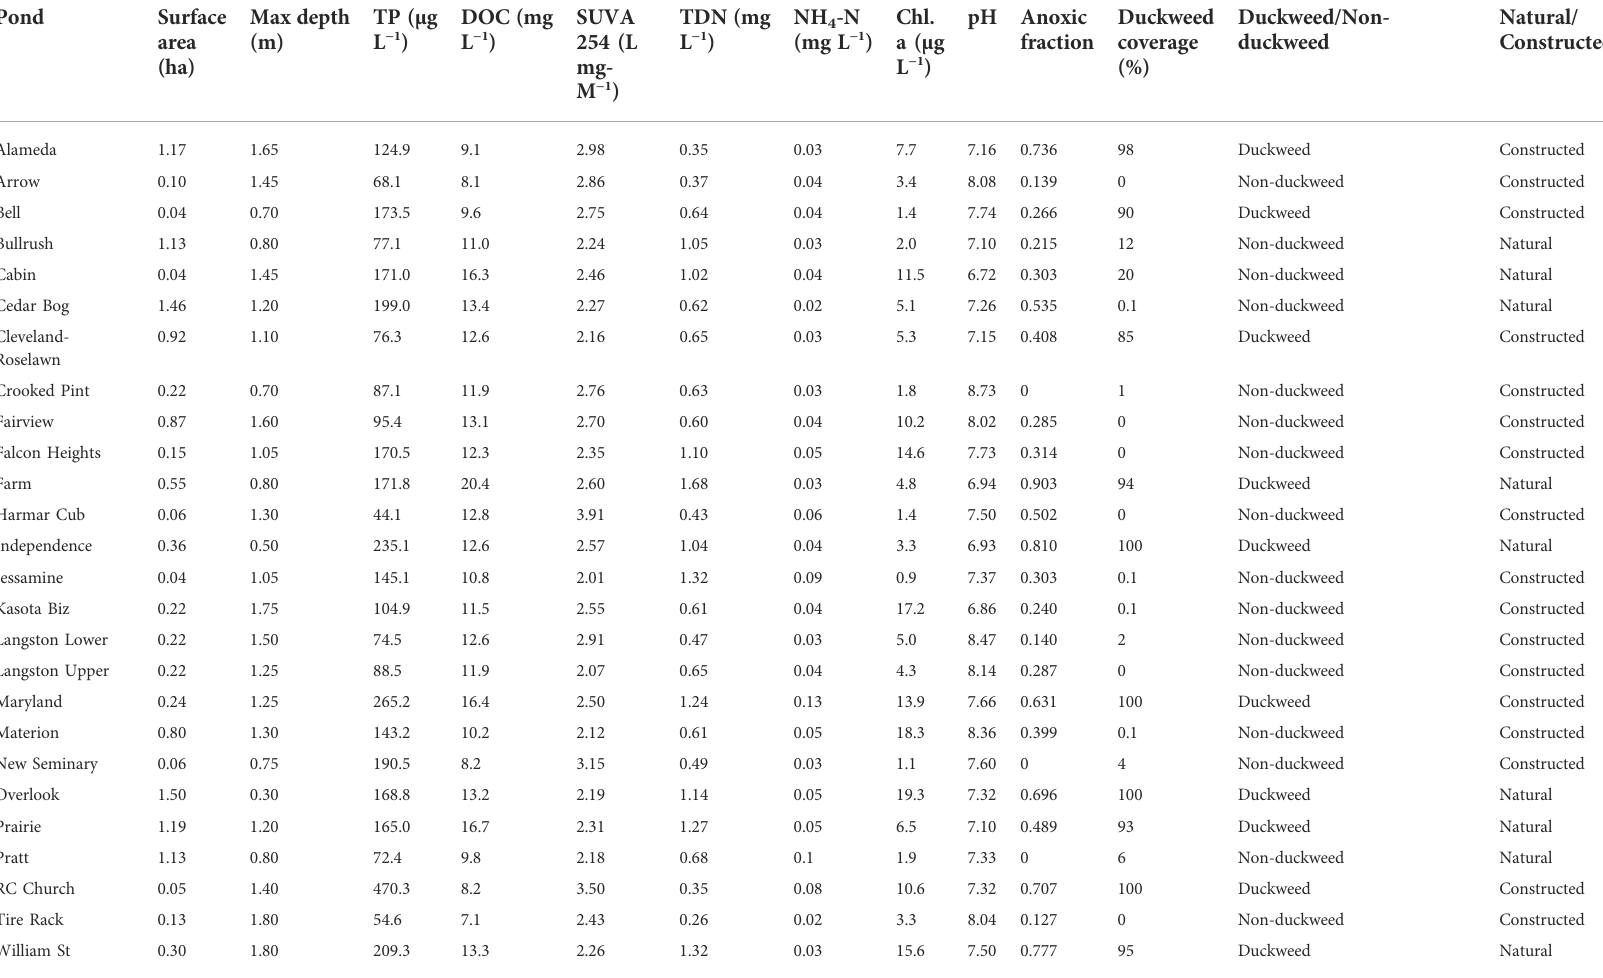
TABLE1Physical,chemical,andbiologicalcharacteristicsofthe26studyponds.Ifduckweedspecieswerepresentbutcoverednegligiblepondsurfacearea,duckweedcoveragewaslistedas0.1%.Anoxic fraction is the anoxic sediment area divided by the pond surface